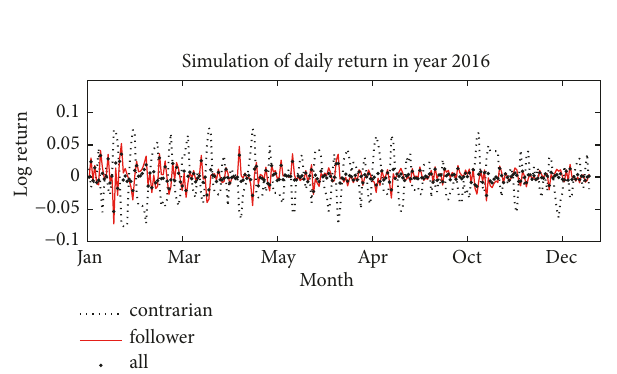
Figure 5: Changes in the return rate separately caused by the contrarians and followers. Here we set 𝛼 =0.002, 𝑅 𝑚 =132. Reference data: daily returns of CSI300 in year